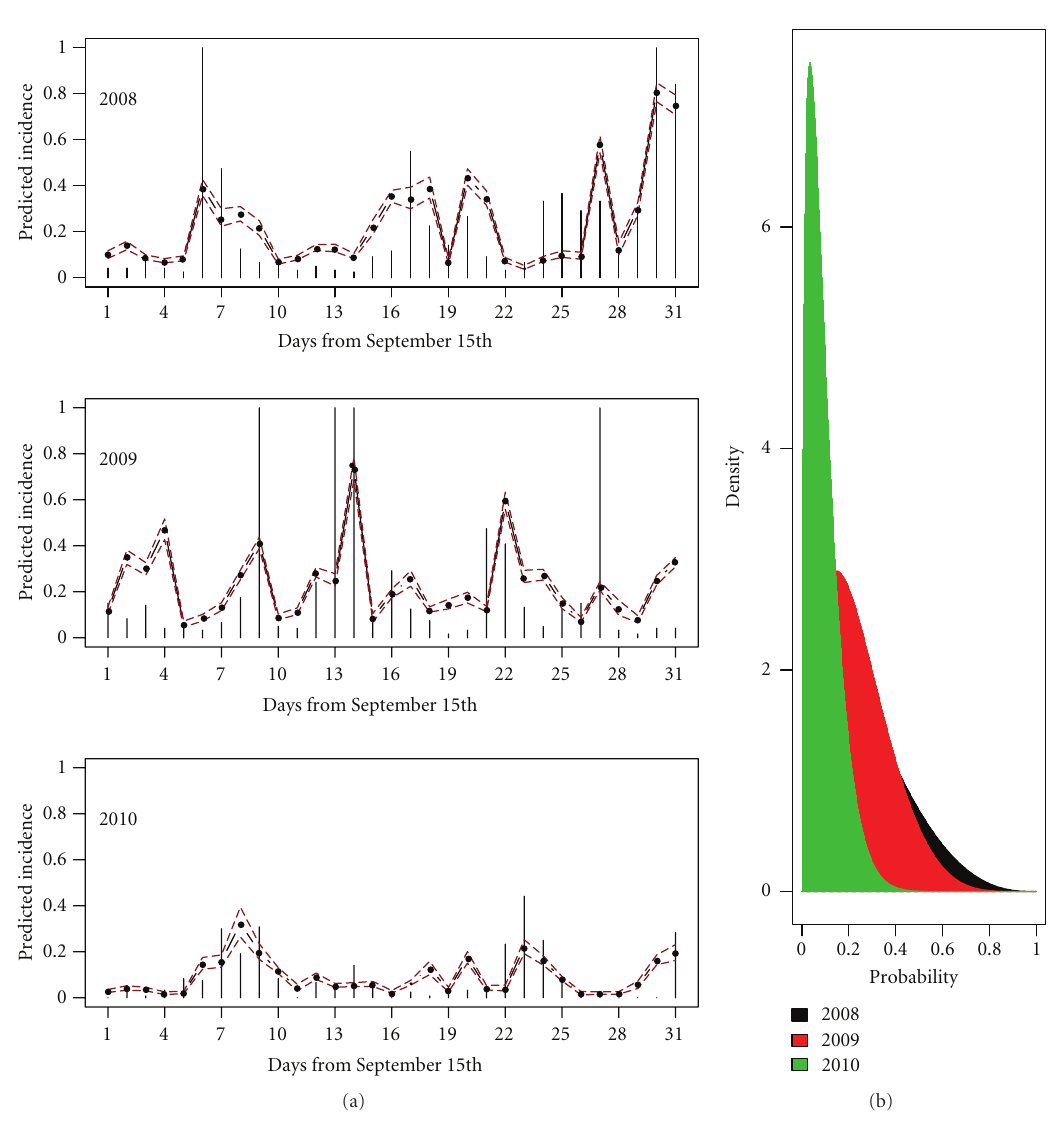
Figure 3: Predicted incidence of spores in a given day by year represented by the continuous line and simulated interval (5, 95 percents) dashed line. The vertical lines represent observed values (a). Estimated density for the beta probability distribution function in the di ff erent years